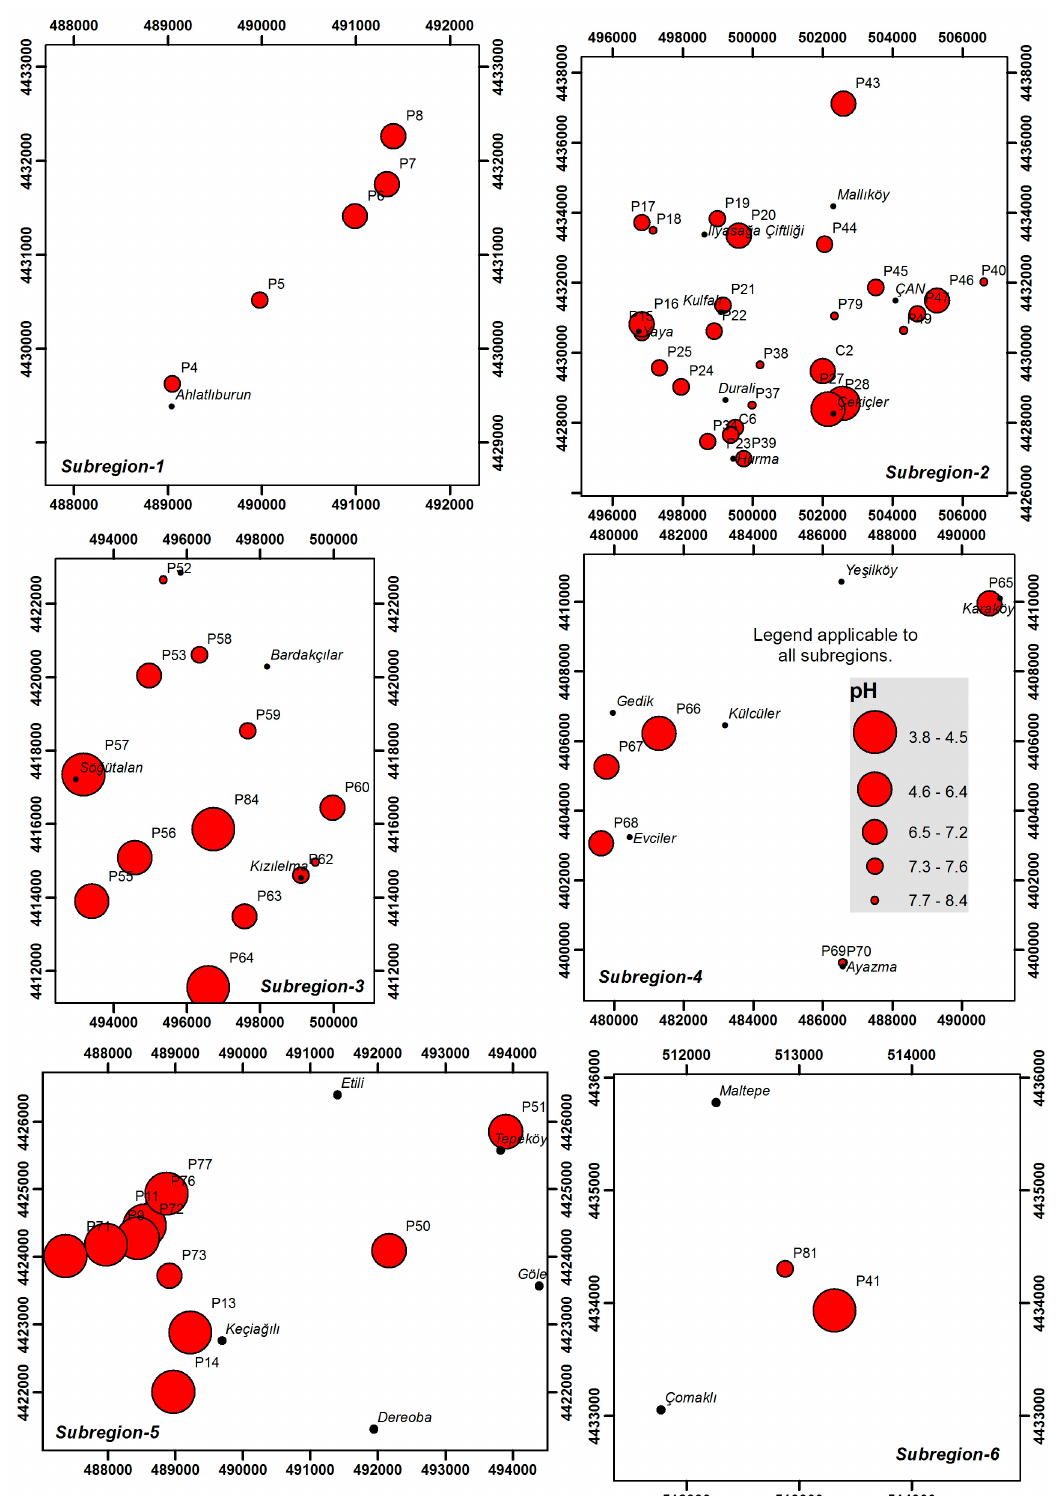
Figure 4. Spatial distribution of pH.